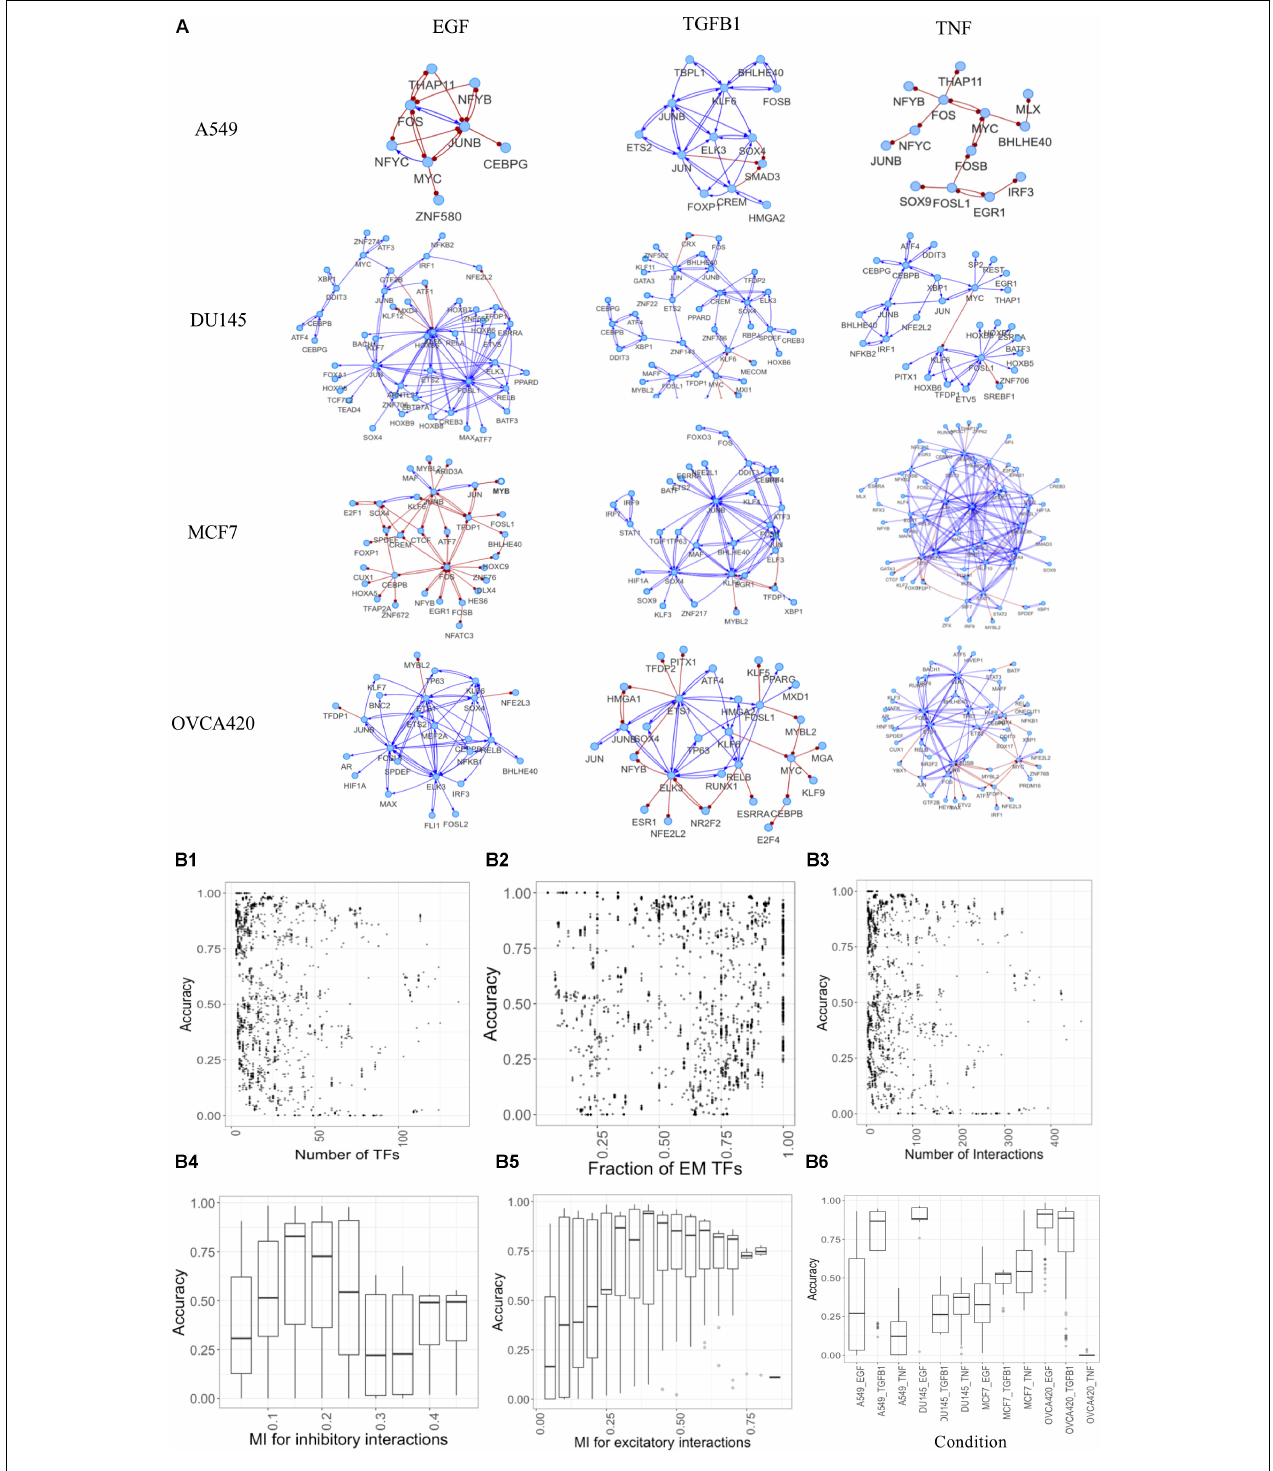
FIGURE 6 | Constructing context-specific gene regulatory networks. (A) Representative networks yielding high accuracy scores for various conditions. Activating interactions denoted as blue arrows and inhibitory interactions as red round-tipped arrows. (B) Accuracy dependence on various network properties for all conditions. (B1–B3) Points showing accuracy (measured as fraction of models that can be classified as E or M) of models for various (B1) number of TFs in the network, (B2) fraction of TFs assigned as E or M using experimental data, (B3) number of interactions in the network. (B4–B6) Box plots showing accuracy of networks for various (B4) mutual information cutoffs for inhibitory interactions, (B5) mutual information cutoffs for excitatory interactions, (B6) different experimental conditions.